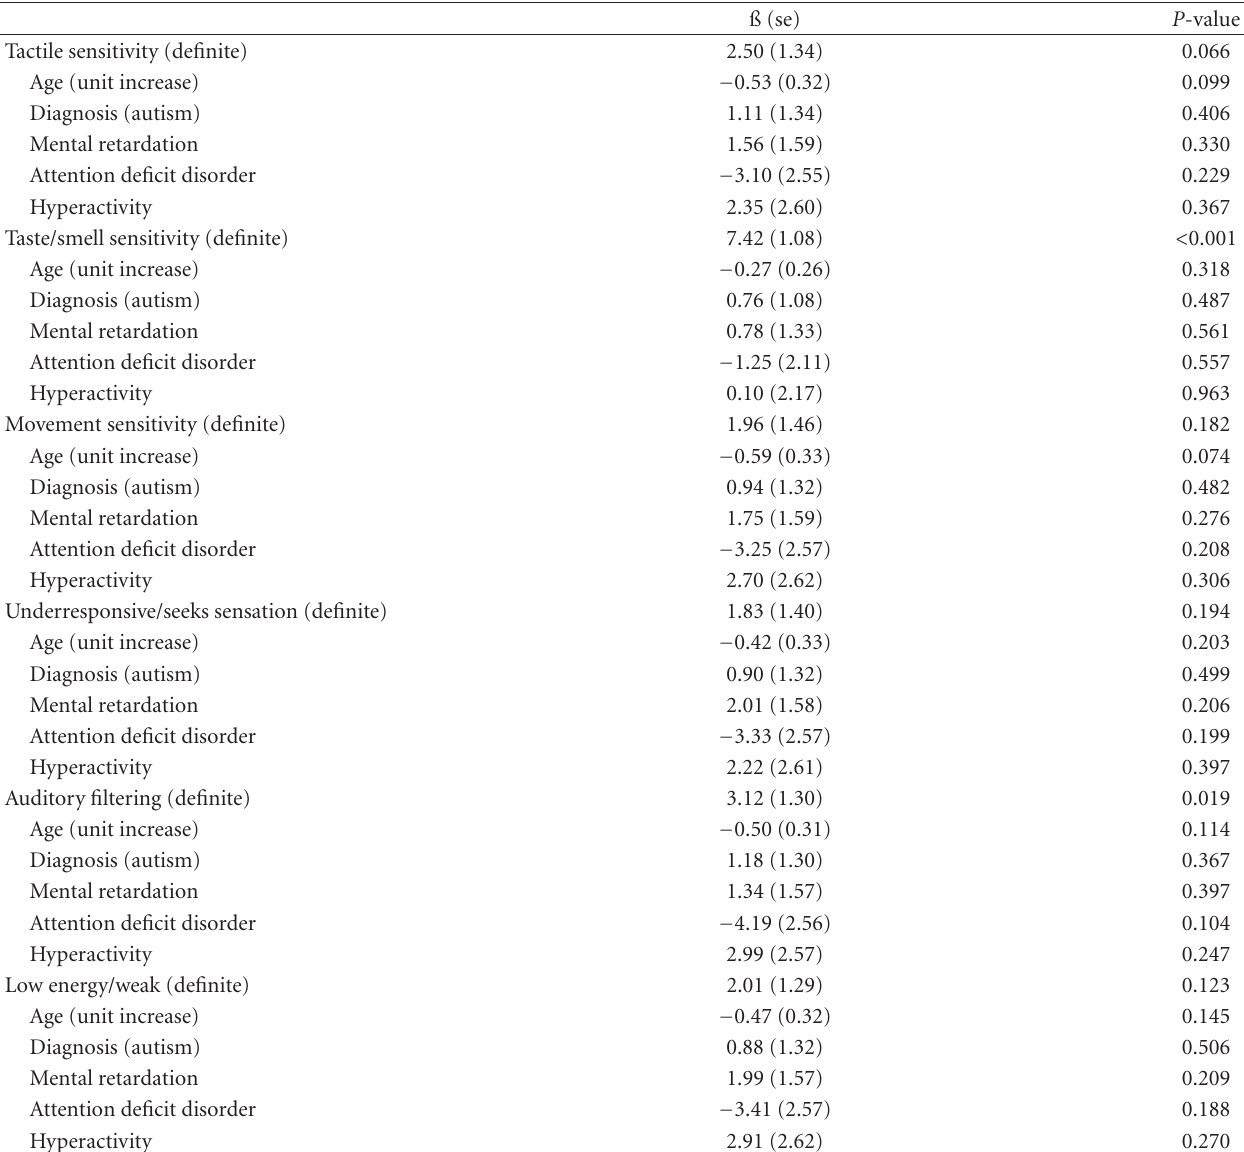
Table 3: Results of multiple linear regression analysis: Association between number of problematic eating behaviors with sensory problems (adjusted for age, diagnosis, mental retardation, Attention Deficit Disorder & Hyperactivity: Autism versus PDD-NOS & Asperger